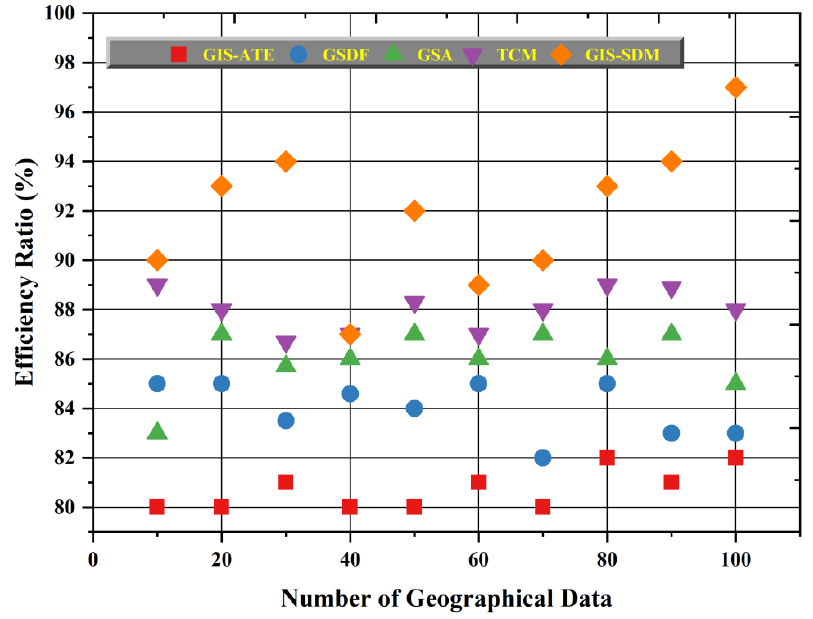
Figure 8. Efficiency ratio of proposed gis-sdm Figure 8. E ffi ciency ratio of proposed gis-sdm model.